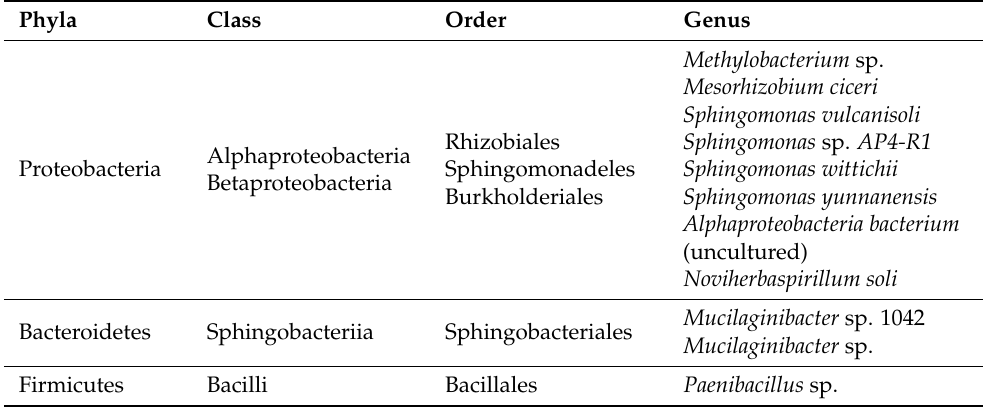
Table 2. Taxonomic classification of the isolated endophytic bacteria from N. caerulescens seeds, cultured on 869 media. The subdivision in ascending order of phylum, class, order, and genus was generated by the NCBI taxonomy browser.